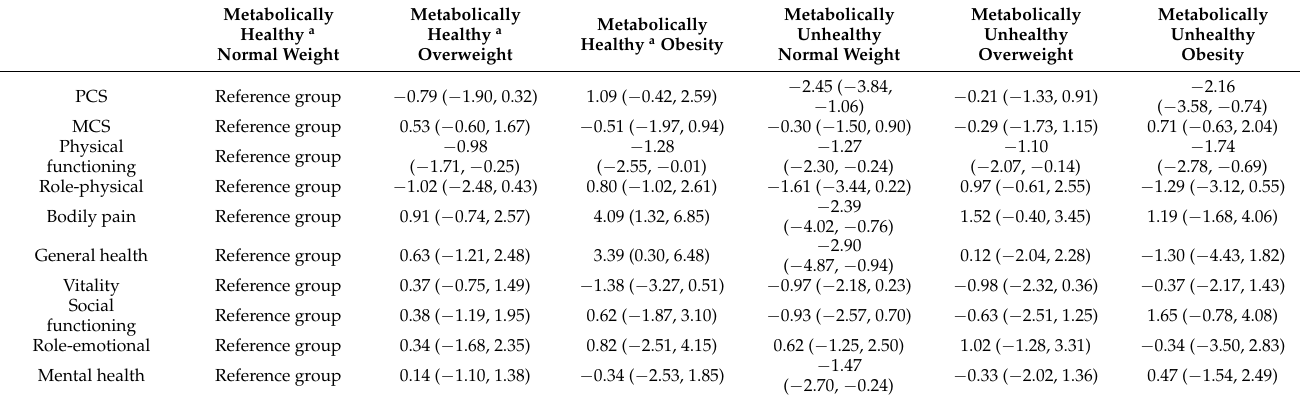
Table 4. Sensitivity analyses to examine the association between metabolic health/BMI groups and health-related quality of life by using another definition of metabolic